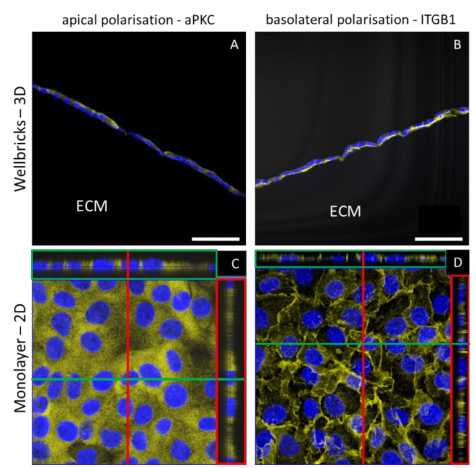
Figure 4. Localisation of in vivo epithelial polarisation markers in three-dimensional (3D) and two-dimensional (2D) culture of Vero E6 cells. Cells were either grown on Wellbricks (3D) or on conventional polystyren plates (2D) for 7 days. The 8 µ m cryosections were prepared for 3D cultures. After permeabilisation the atypical protein kinase C (aPKC) as apical marker ( A,C ) and integrin beta 1 (ITGB1) as basal marker ( B,D ) were visualised with polyclonal antibodies and AF647 (yellow) coupled anti-rabbit secondary antibodies. Cellular nuclei were counterstained with DAPI (blue). Digital sections of 2D cultures in z-direction were generated by overlay of 30 single frames ( C , D ) and are shown on the right of each picture in red boxes and on top of each picture in green boxes. Scale bar = 50 µ